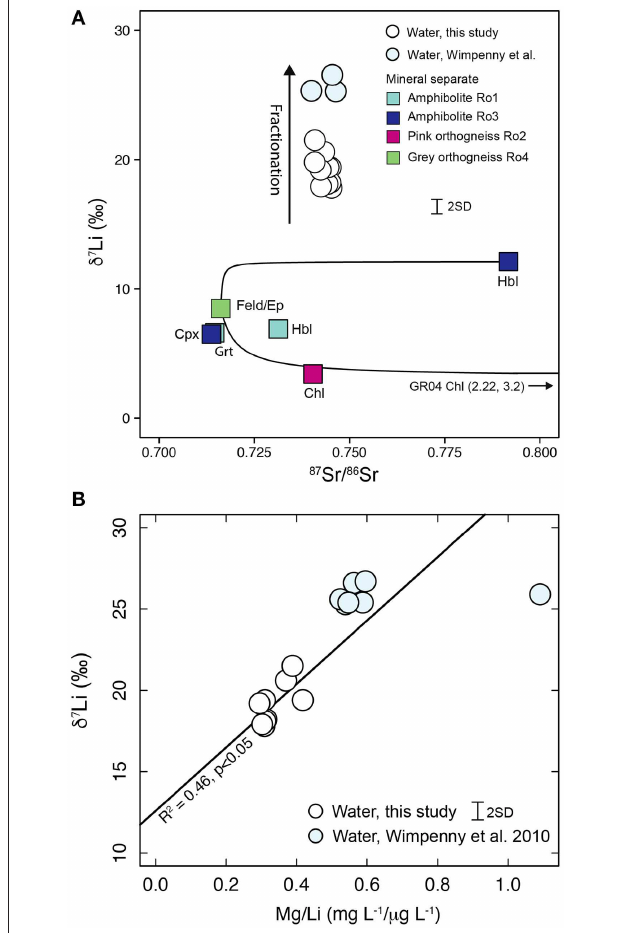
FIGURE 6 | (A) Mixing between the minerals of Ro4 (feldspar, epidote, and chlorite) cannot explain the δ 7 Li values of water. Hornblende, the mineral with the highest δ 7 Li values, also cannot account for the water δ 7 Li values, even if it dominated the dissolved Li budget. Therefore, although some variation may be attributable to mineral source heterogeneity a fractionation process must also be occurring. Mineral abbreviations: Hbl, Hornblende; Chl, Chlorite; Cpx, Clinopyroxene; Grt, Garnet; Feld/Ep, K-feldspar, plagioclase, epidote mixture. Note that a change in the relative proportion of garnet weathering will have a negligible effect on δ 7 Li ratios. (B) The water samples measured in this study have lower δ 7 Li and Mg/Li values compared to Wimpenny et al. (2010). The lower Mg/Li values would be consistent either with a lower relative loss of Li compared to Mg or with a decreased contribution from garnet weathering (Mg/Li garnet = 2.1, Figure 5B ). The solid line is the regression through Leverett River